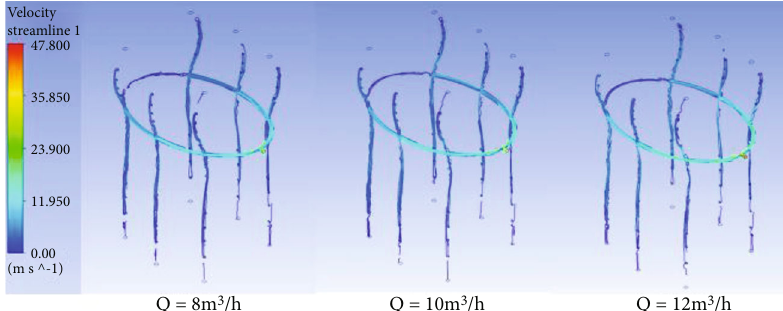
Figure 6: Velocity streamline fi gure of transverse type.